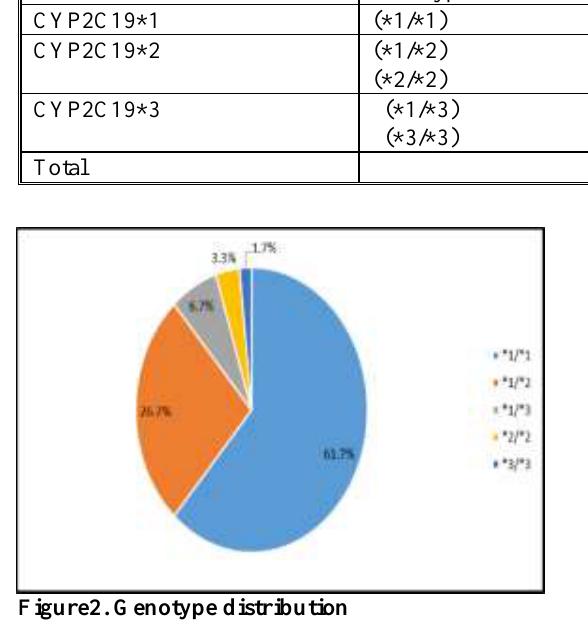
Figure2. Genotype distribution CYP2C19 polymorphism and risk of stroke recurrence